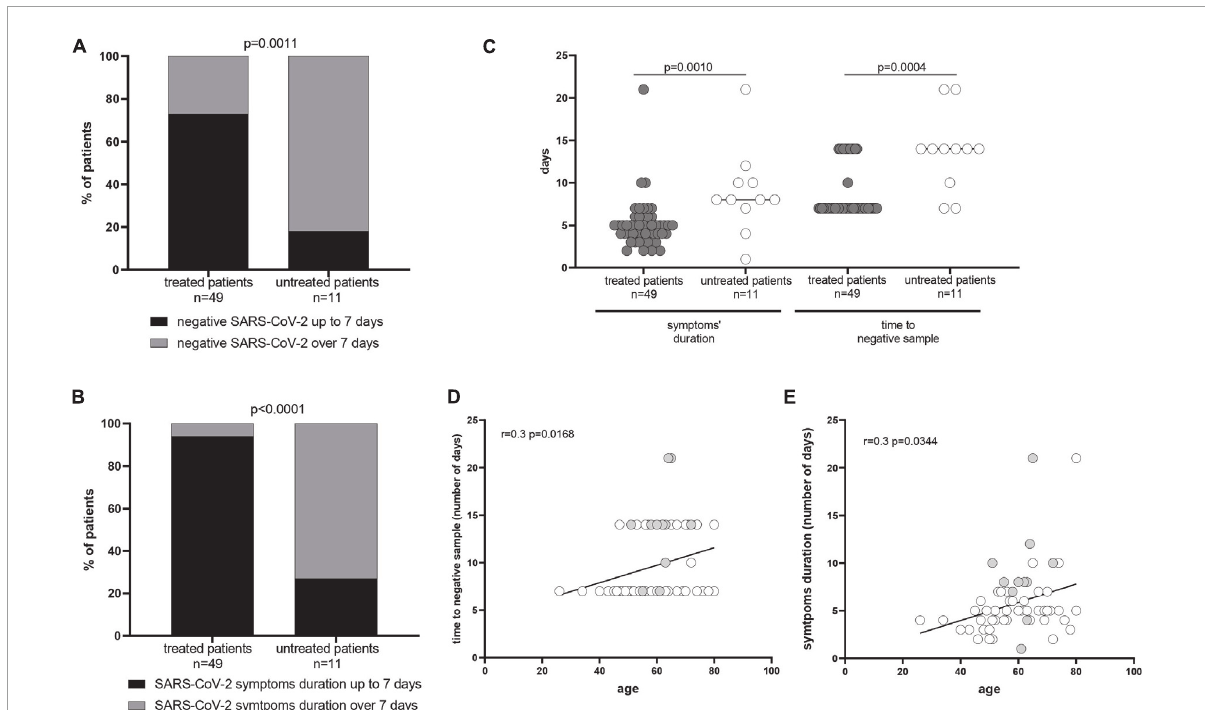
FIGURE1 Time to negative severe acute respiratory syndrome coronavirus 2 (SARS-CoV-2) respiratory sample and symptoms’ duration. The percentage of treated and untreated patients with negative SARS-CoV-2 by 7 days and the symptoms’ duration up to 7 days from the symptoms onset are showed in (A,B) , respectively. The median time to negative sample in treated patients was 7 days [interquartile range ( IQR ) 7–12)] while it reached 14 days ( IQR 10–14) in the control group ( p = 0.0004). The p -values were calculated using Fisher’s exact test and given in each graph. In (C) , the median number of days of positive SARS-CoV-2 RNA and symptoms’ duration have been reported in treated and untreated patients, and p- values were measured using the Mann–Whitney test. A correlation between the age and the symptoms’ duration (D) as well as the age and the number of days of positive SARS-CoV-2 RNA (E) was measured using the Spearman test, showing separately treated (gray dots) and untreated patients (white dots).